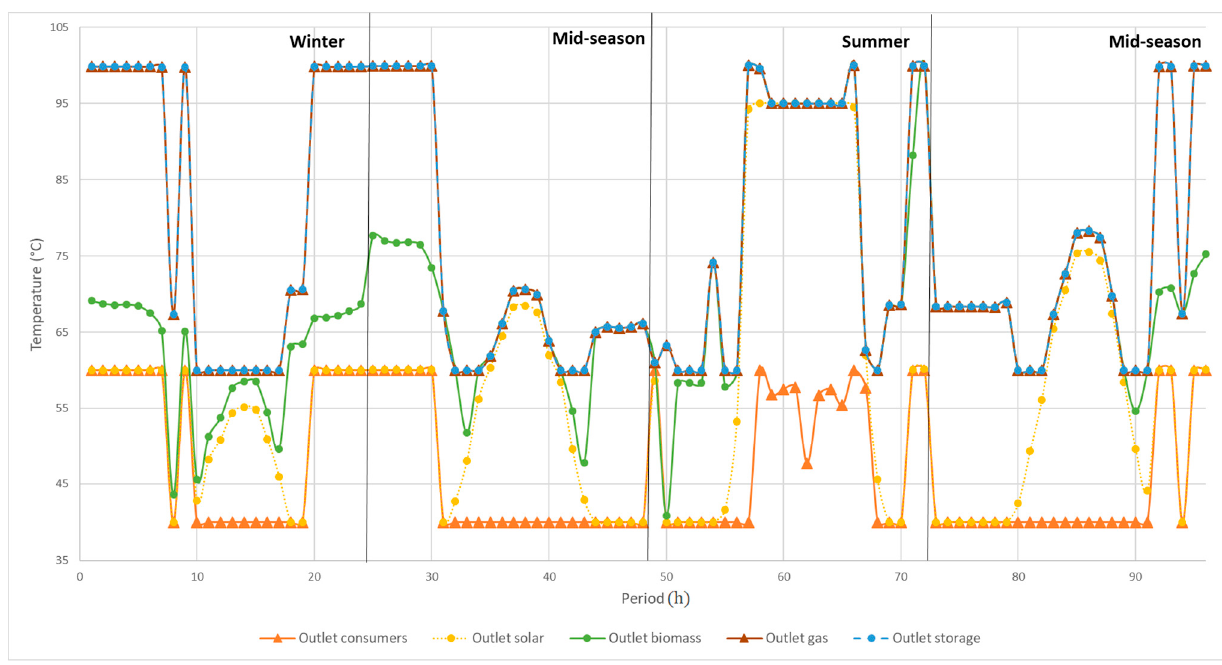
Figure 14. Temperature at different points of the DHN (connection 1).